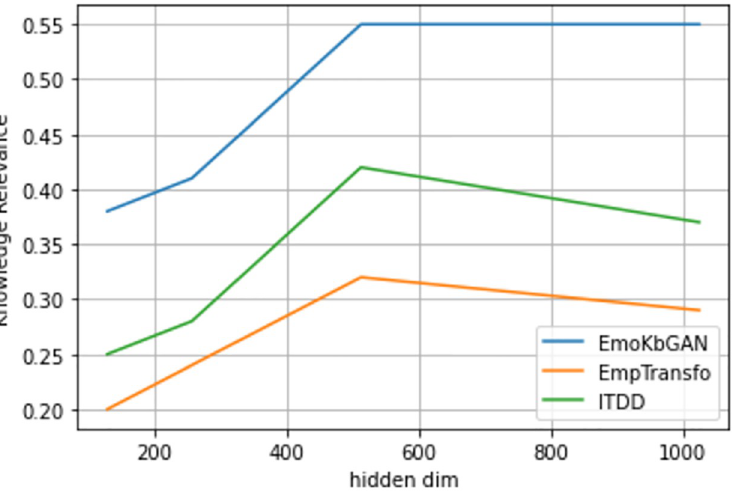
Fig 4. Knowledge relevance vs hidden